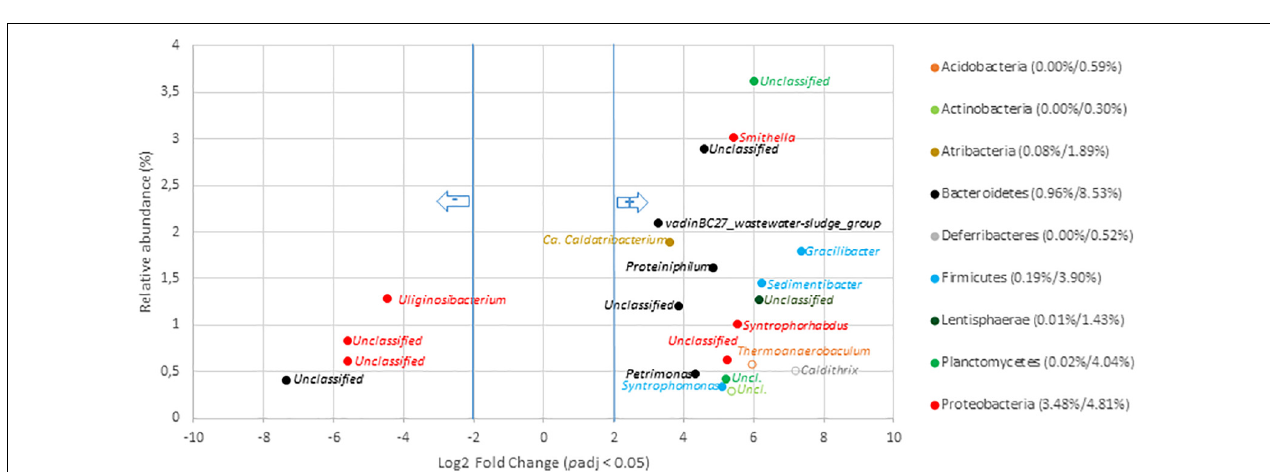
FIGURE 5 | Genera with significant change in relative abundance after anaerobic digestion of raw organic wastes samples from urban origin. Genera with significant ( p adj < 0.05) decrease in digestates compared to raw OW samples (left part of the plot) are presented according to their initial relative abundance in raw OW. While genera with significant increase in digestates compared to raw OW samples (right part of the plot) are presented according to their relative abundance in digestate. Genera are colored according to the phylum to which they belong. Full mark represents genus present in the core microbiome while empty mark represents genus not present in the core microbiome (raw OW and digestate core microbiomes were, respectively, considered at the left and right part of the plot). Numbers in brackets represent the sum at the phylum level of relative abundances of all genera with significant change after AD calculated before and after AD (raw OW%/digestate%). Only genera with relative abundance ≥ 0.3% and significant change (-2 ≥ Log2 FC ≥ +2, p adj < 0.05, minimum normalized read count = 10) are shown (see Supplementary Table 11 for the other